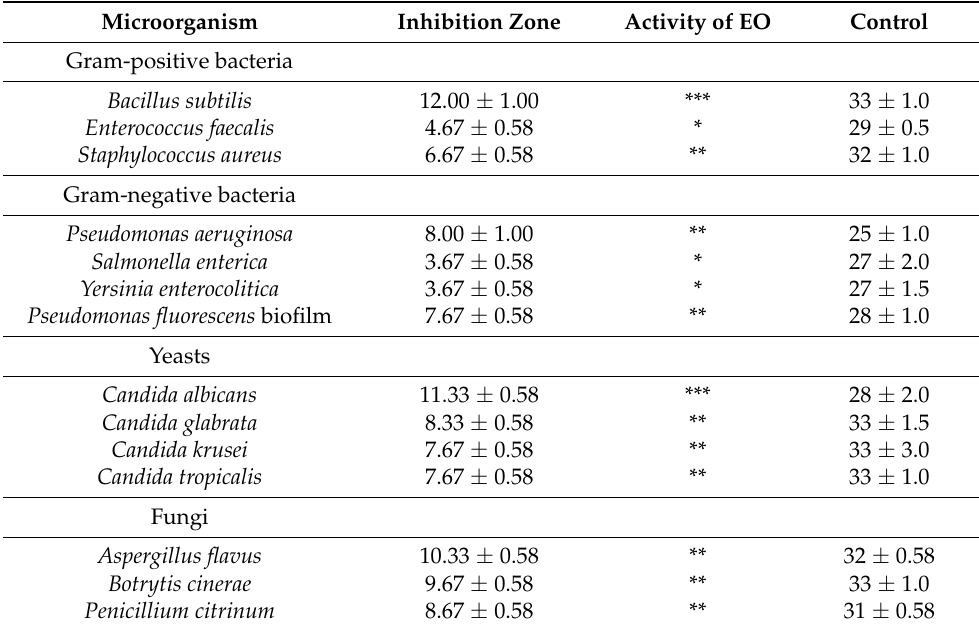
Table 3. Antimicrobial activity of SSEO in mm.